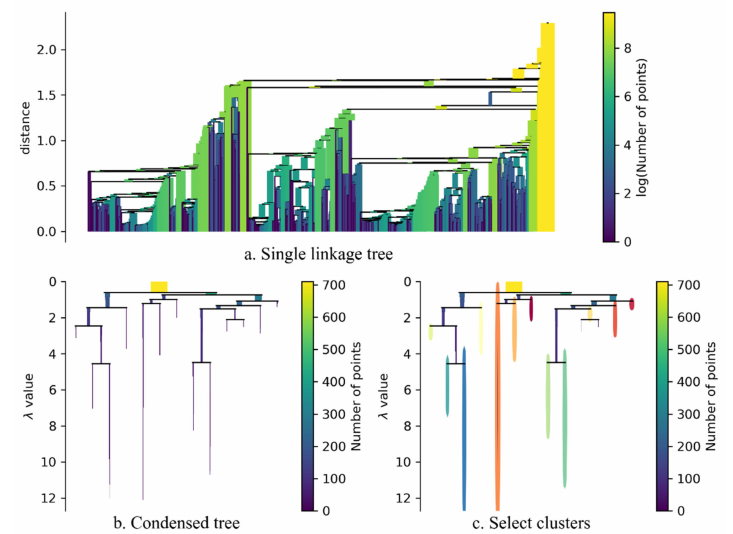
Figure 6. The procedure of HDBSCAN.